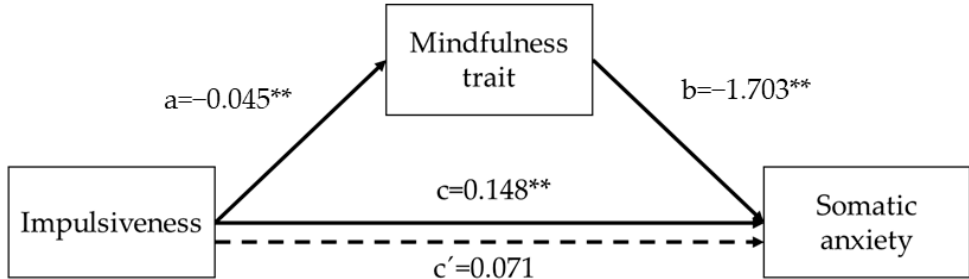
Figure 2. Graphical representation of the mediation effect of mindfulness in the association between impulsiveness and somatic anxiety. The numerical values correspond to the unstandardized regression coefficients. Dashed line represents the mediated association. ** p < 0.01.